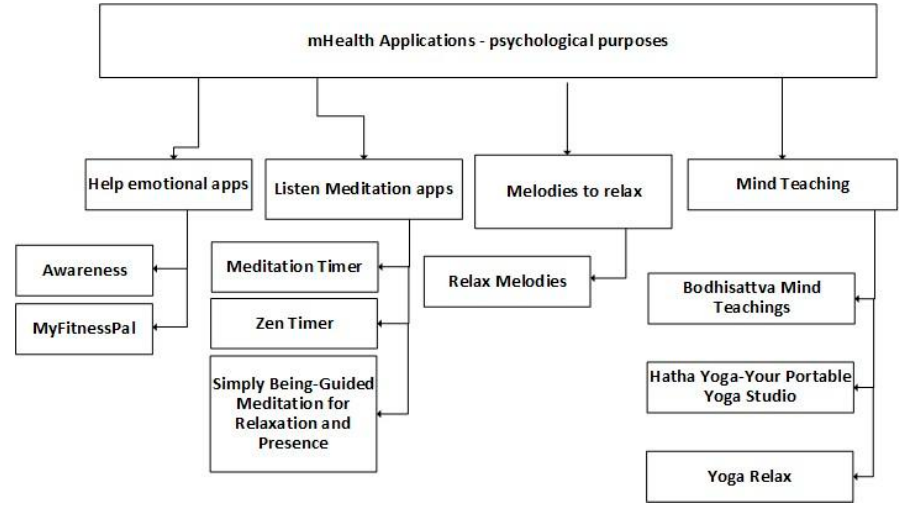
Figure 6. Classification of mobile health applications related to psychological purposes.